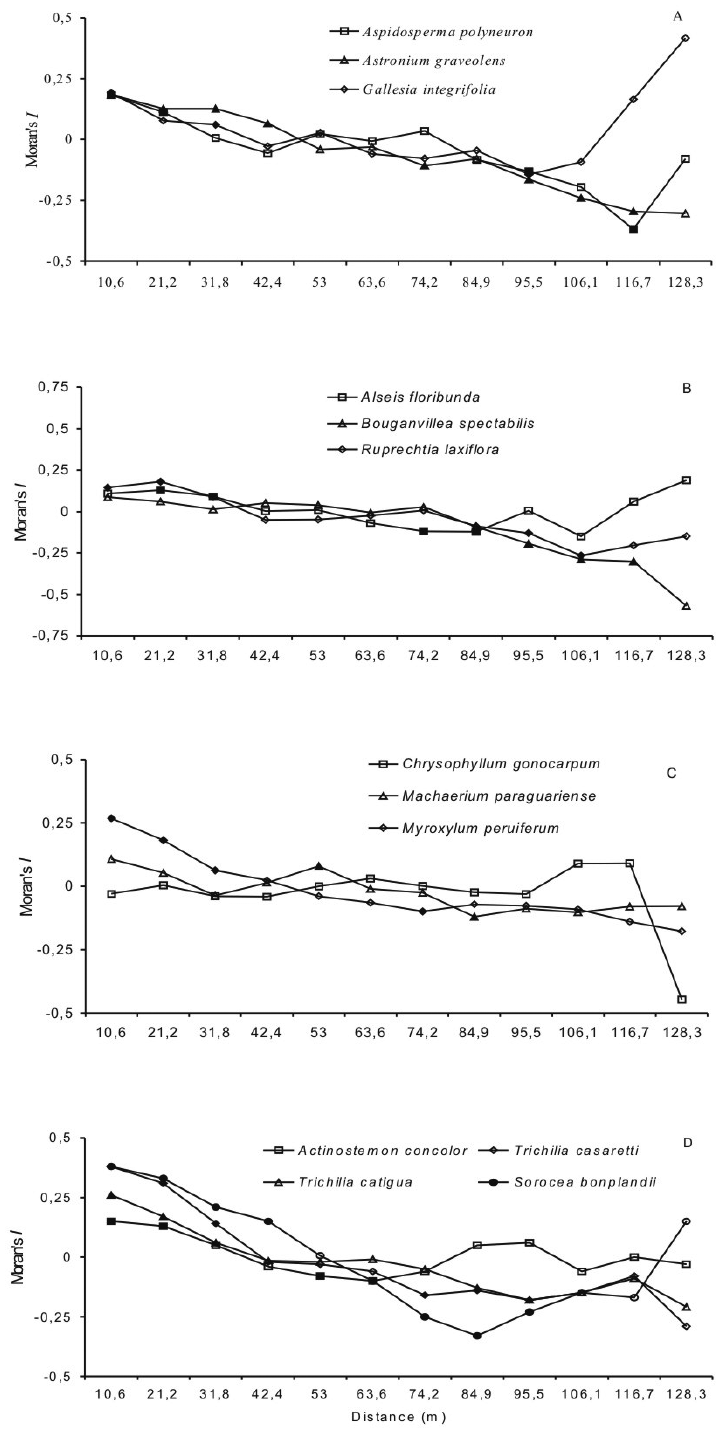
Fig. 2 – Spatial correlogram of 13 tree species density in a riparian forest fragment in Fazenda Doralice, Ibiporã, Paraná State, Brazil. A – emergent trees; B – shade-intolerant canopy trees; C – shade-tolerant canopy trees; D – small understory trees. The abscissa corresponds to the upper limit (m) of each distance class. Black points indicate significant Moran’s I values at the α = 5% level (for globally significant correlograms), and white points are non-significant